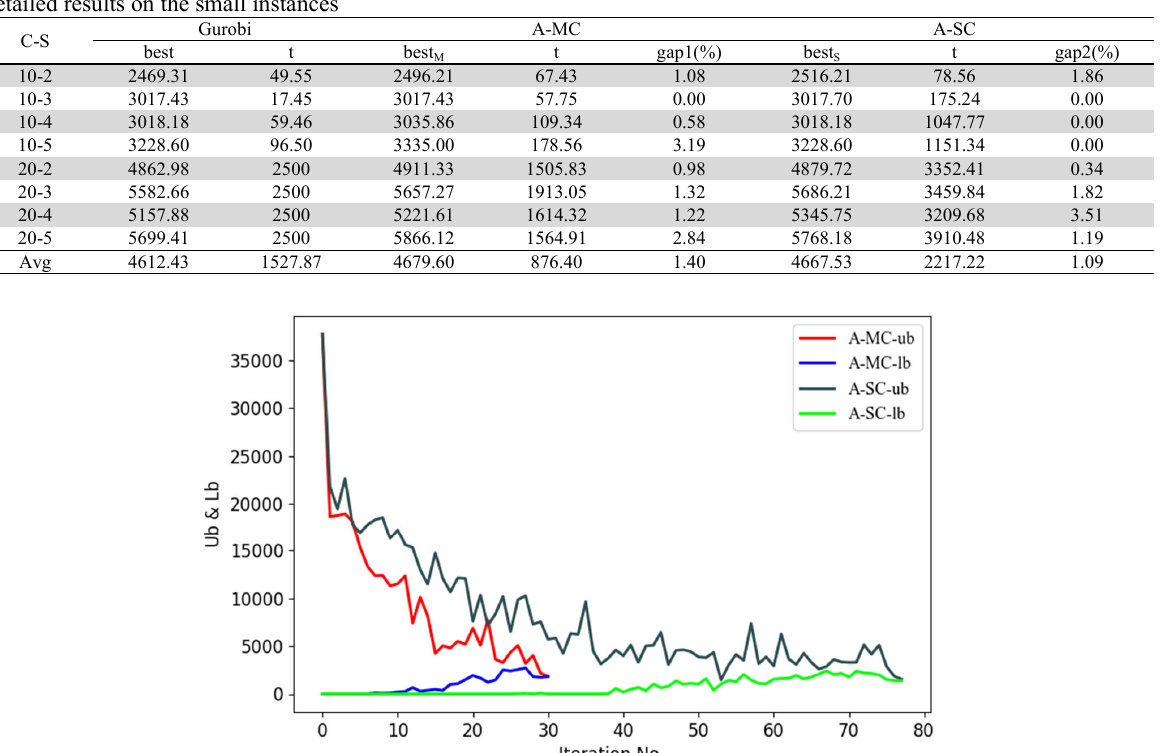
Fig. 2. Iterative process of the upper and lower bounds for subproblem of the 20-5